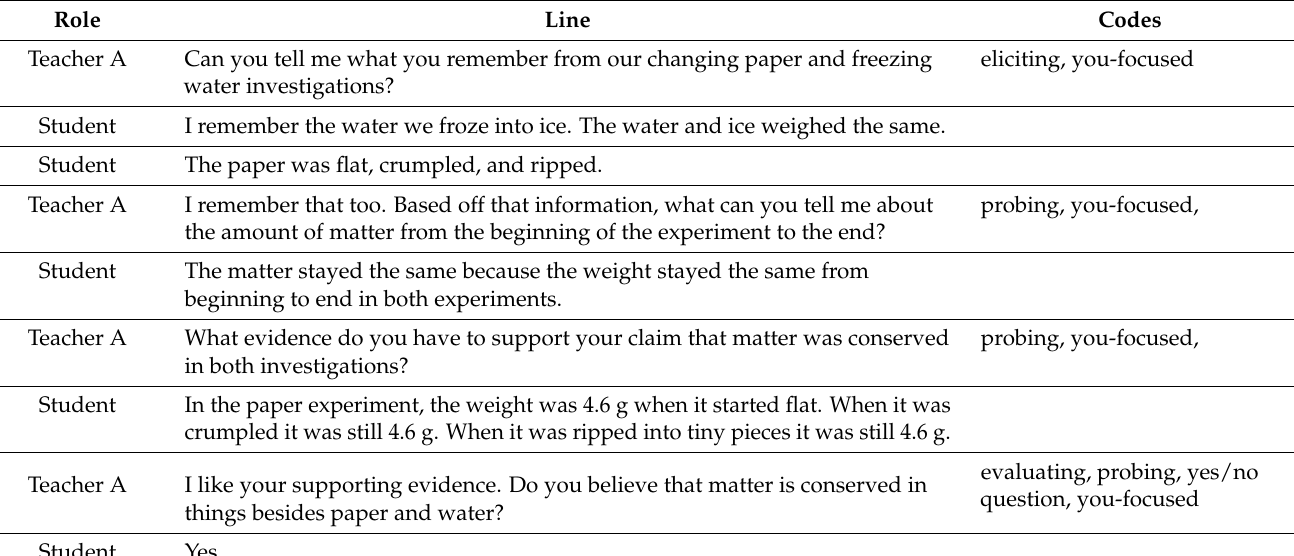
Table 6. Example conversation with more productive than counterproductive questioning